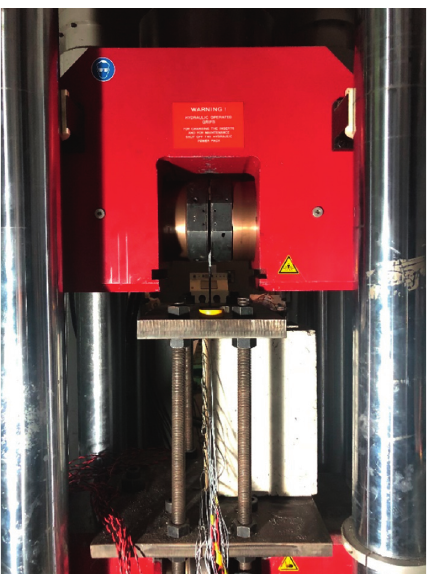
Figure 5: Specimen installation.